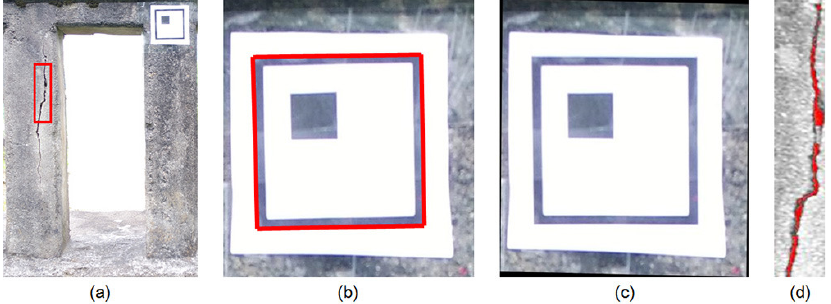
Figure 5. Image processing procedure of crack length and thickness estimation: ( a ) Image capture; ( b ) Marker detection; ( c ) Calculation for fixel size and ( d ) Crack quantification.